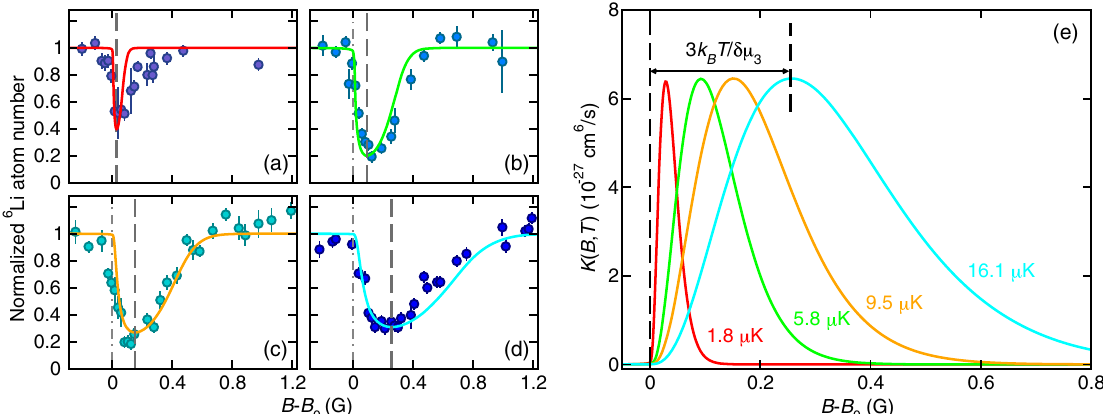
FIG. 5. Fermionic behavior of three-body recombination processes in 6 Li and 173 Yb mixtures found in atom-loss spectra and fitted − 1 = 2 ; 0 i state and 173 Yb in the j m ; m theoretical line shapes as functions of magnetic field. 6 Li is prepared in the j m s; Li i; Li i ¼ j i; Yb i ¼ j þ 5 = 2 i state. The hold time is 4 s. Panels (a) – (d) correspond to the remaining 6 Li atom number normalized to the remaining fitted 6 Li atom number away from the resonance (markers with error bars) as a function of B − B 0 measured at temperatures of f 1 . 8 ; 5 . 8 ; 9 . 5 ; 16 . 1 g μ K, respectively. The initial atom numbers for Li (Yb) are f 1 . 3 ð 1 . 0 Þ ; 1 . 7 ð 3 . 3 Þ ; 1 . 3 ; ð 2 . 0 Þ ; 1 . 8 ð 4 . 0 Þg × 10 5 and the initial peak densities for Li (Yb) are f 6 . 1 ð 2 . 6 Þ ; 12 ð 8 . 3 Þ ; 10 ð 6 . 2 Þ ; 11 ð 9 . 3 Þg × 10 12 cm − 3 . The fitted theoretical line shapes are the colored curves. We specify the magnetic field relative to the resonance location B 0 as determined from the fit. The dash-dotted and dashed lines, where given, locate the fitted resonance location B 0 and the field of maximum atom loss, respectively. The vertical axes are scaled to the theoretical background values away from the resonance. The magnetic moment of the trimer resonance state is 2 . 8 μ 6 × 10 − 6 nK, and Γ 100 nK. The one-body loss rate is Γ 0 . 1 s − 1 for our δμ =k , while B 0 ¼ 640 . 476 G, A=k 3 ¼ B B ¼ B ¼ br bg ¼ lowest temperature and 0 . 075 s − 1 otherwise. Panel (e) shows the theoretical event rate coefficients as functions of B − B 0 for our four temperatures. The line colors correspond to those used in (a) –